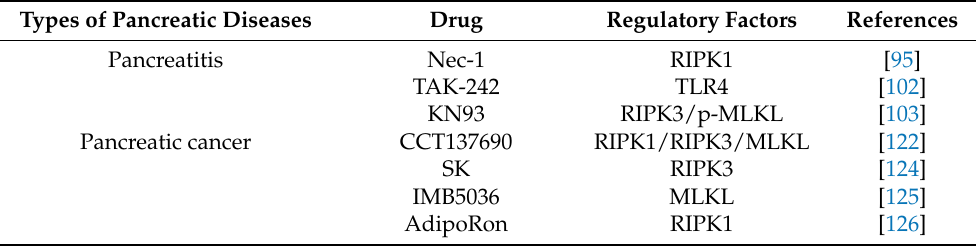
Table 3. Therapeutic drugs in pancreatitis and